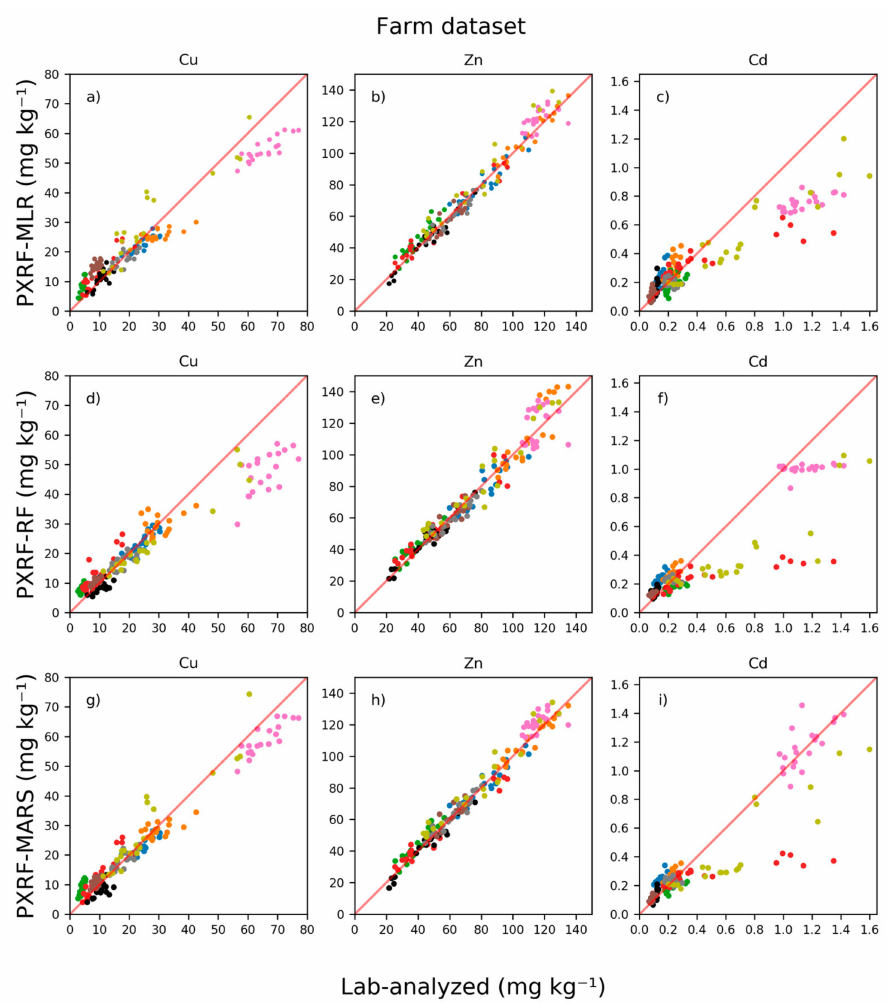
Figure 3. Concentrations of copper (Cu), zinc (Zn), and cadmium (Cd) predicted from portable X-ray fluorescence (PXRF) measurements using multiple linear regression (MLR), random forest regression (RF), and multivariate adaptive regression splines (MARS) on the farm dataset compared with 7M HNO 3 extraction and inductively coupled (ICP) analysis. The models were calibrated at the national scale and applied on the farm dataset. Each color represents a specific